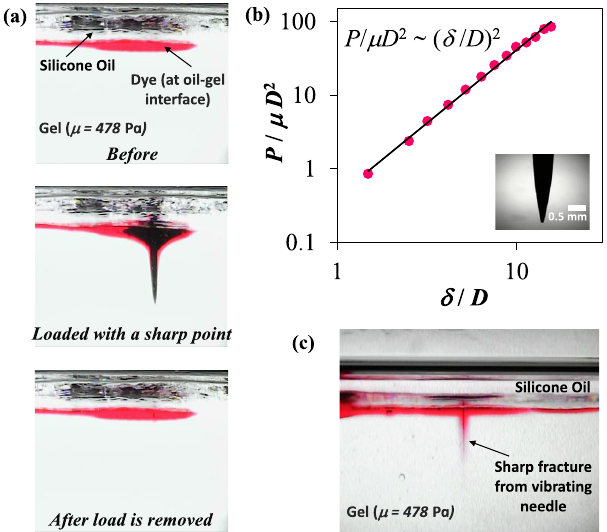
FIG. 7. (a) Snapshots of the experiment of loading a needle (diameter D and grafted with about 5-nm layer of polydime- thylsiloxane chains) inside the gel with a thin layer of silicone oil (AR20, Sigma Aldrich) on its surface. The oil above the gel reduces friction by lubricating the contact between the needle and the gel during indentation. The red dye demarcates the interface between the gel and silicone oil. After unloading the needle from the gel, the dyed interface retracts to its original position, showing that there was no fracture in the gel. (b) For these experiments of loading a sharp needle (inset) inside the gel ( μ ¼ 478 Pa), the nondimensional force P= μ D 2 varies almost as the square of the nondimensional displacement δ =D . An uncertainty analysis yields the value of the power of δ =D as 1 . 99 (cid:2) 0 . 03 . (c) When the same needle is indented in the gel while undergoing vertical vibrations, a fine fracture is induced by the indentation. The needle undergoes square-wave oscillations (amplitude of vibra- tion of about 0.64 mm) along its axial direction, which were generated by a waveform generator (Agilent, Model 33120A), connected to a mechanical oscillator (Pasco Scientific, Model No: SF-9324) via an amplifier (Sherwood, Model No: